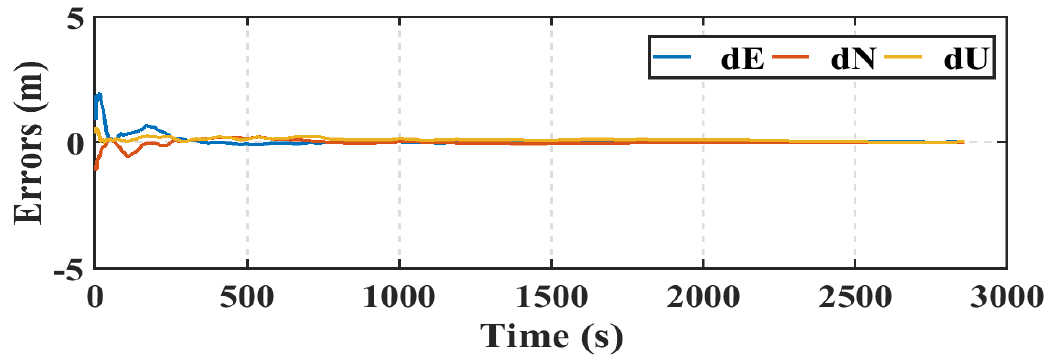
Figure 12. Smartphone PPP solution errors in East, North, and Up directions (dE, dN, dU).